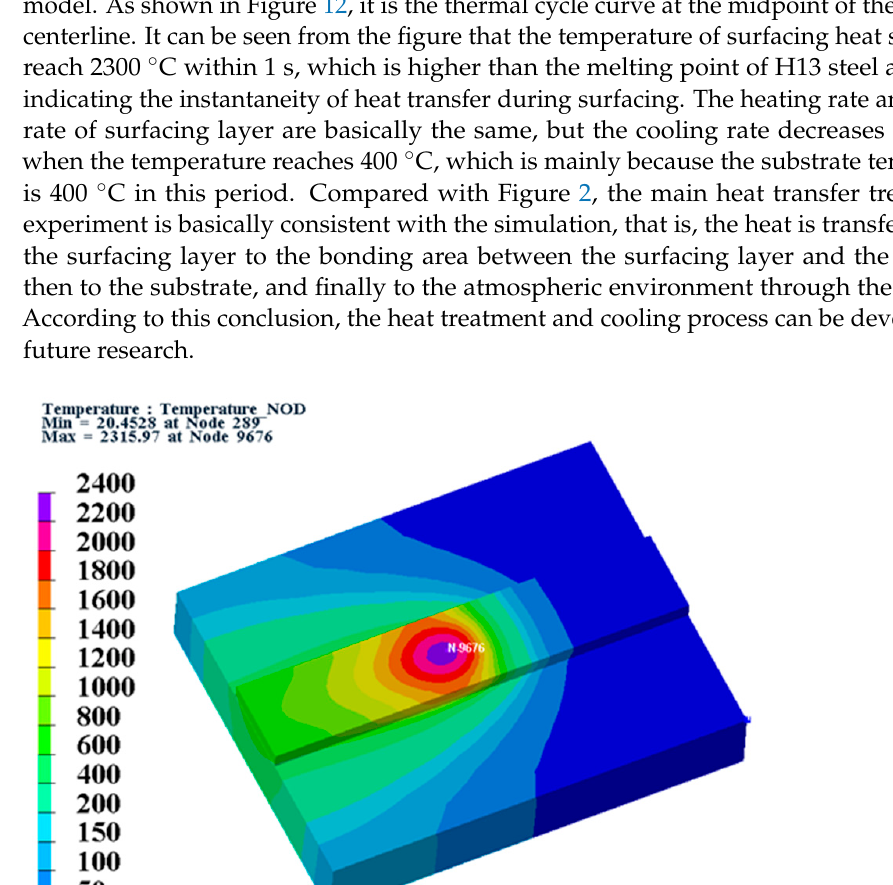
Figure 12. The temperature cycle at the midpoint of the centerline of the surfacing layer. 4.3. Analysis of Simulation Stress Field During the surfacing welding process, multiple temperature gradient intervals are generated on the surfacing welding parts, and different surfacing residual stress fields